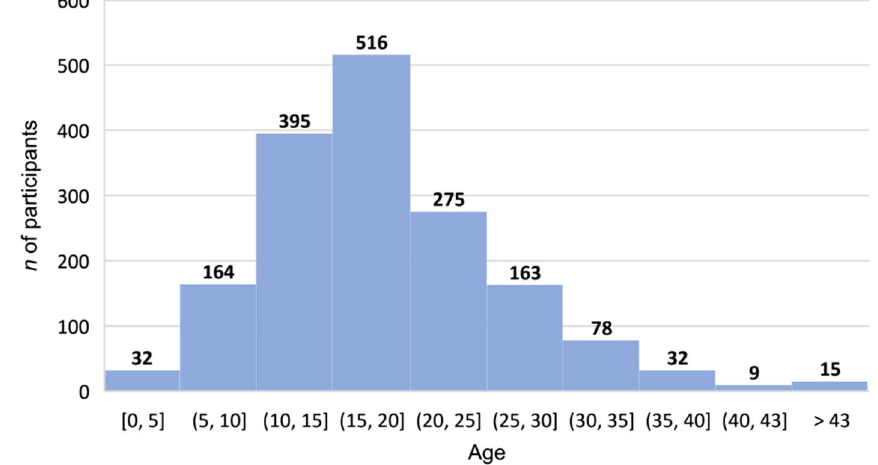
Fig. 1 Age at MwoA